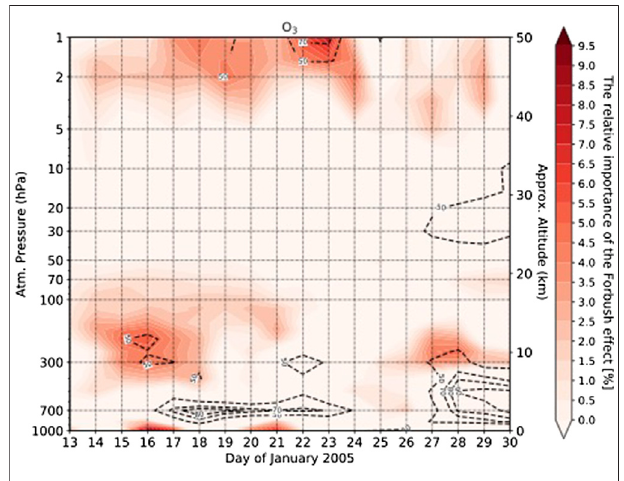
FIGURE 4 | The ozone effect induced by a strong decrease in HO x radical over the northern polar atmosphere (90N-75N) during Forbush decreases of January 2005. Dashed lines: the con fi dence level [in